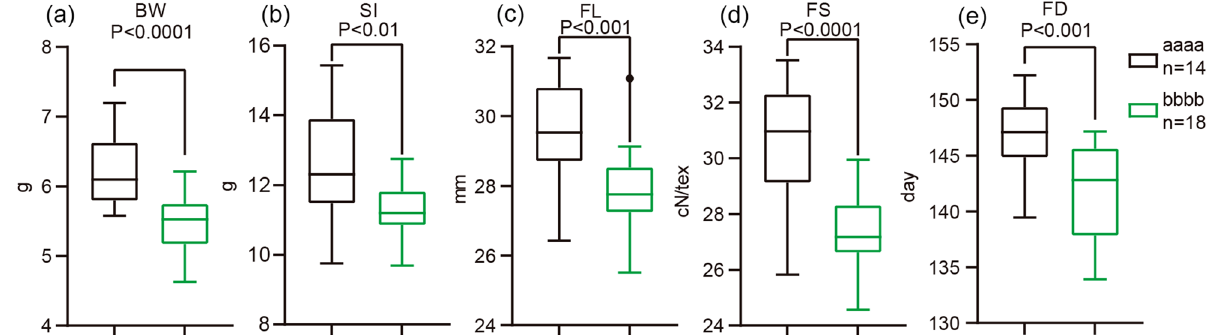
Figure 5. Genotyping of the five class (class_1 to class_5). ( a – e ) Violin plot for BW, SI, FL, FS and FD. Center line (red), median; box limits, upper and lower quartiles; whiskers, 1.5× the interquartile range. P values in this were derived with two-sided t-test. The figure was created by the software GraphPad Prism 9 (ver. 9.0.0, http:// www. graph pad.